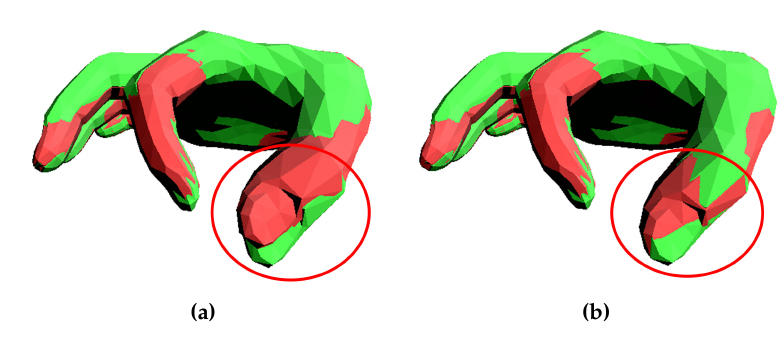
Figure 4. Fitting MANO hand model to the data set in [44]. Green one represents the data set, while red one is the fitted MANO model. ( a ) The IP joint with only one degree of freedom (DoF). ( b ) The IP joint with three